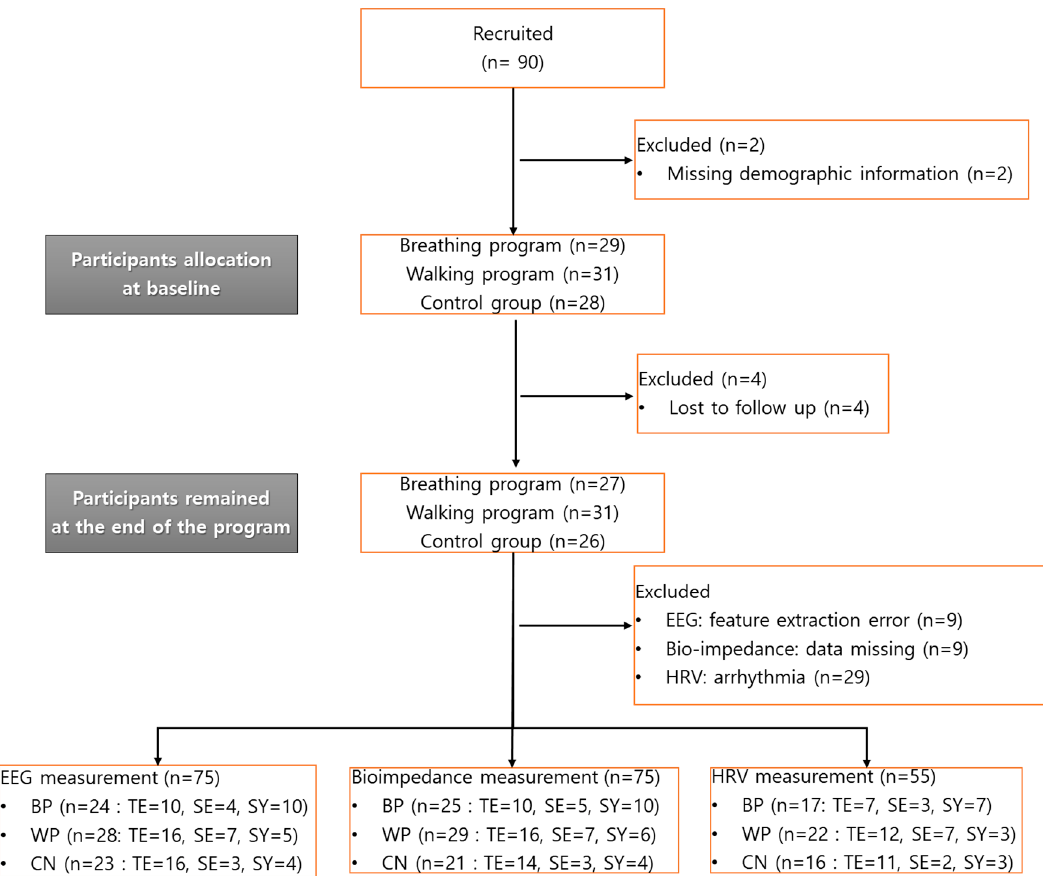
Figure 2. Flow chart of the study. HRV, heart rate variability; BP, guided-breathing meditation program; WP, walking program; CN, control; TE, Tae-Eum; SE, So-Eum; SY, So-Yang.